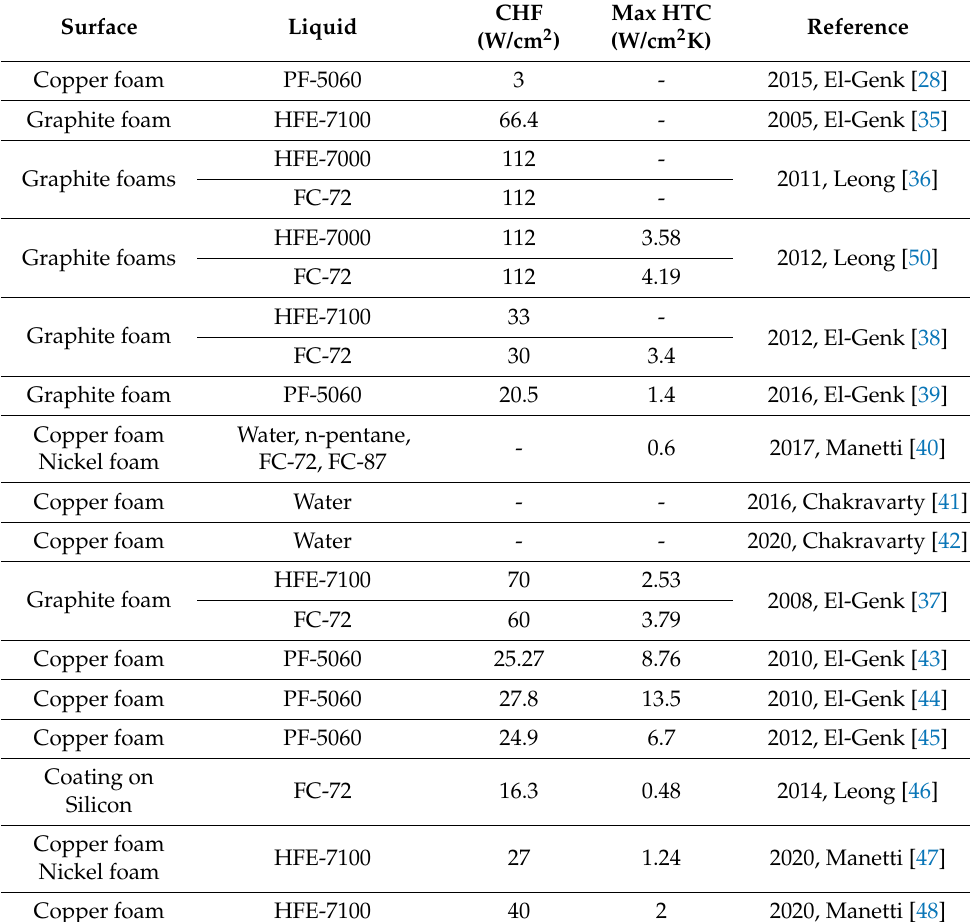
Table 3. Experiments with a porous